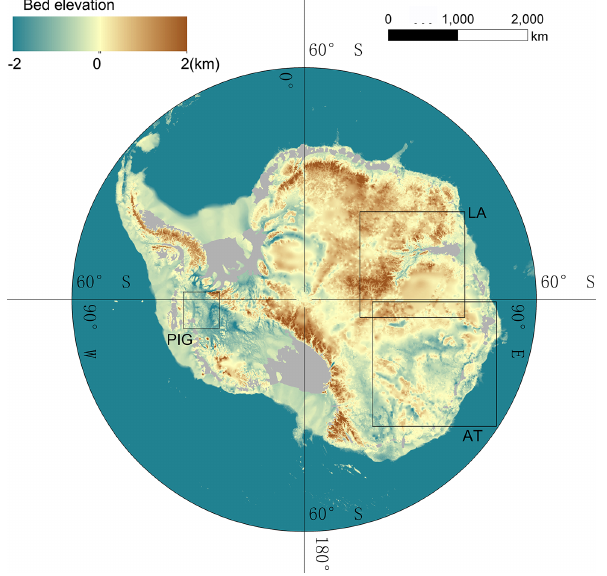
Figure 1. The three basins (boxed) we simulated on the Bedmap2 Antarctic bedrock topography map (Fretwell et al., 2013). Pine Is- land Glacier (PIG) is shown in Fig. 2a, Lambert–Amery (LA) sys- tem is shown in Fig. 2b and the Aurora-Basin–Totten-Glacier region (AT) is shown in Fig.